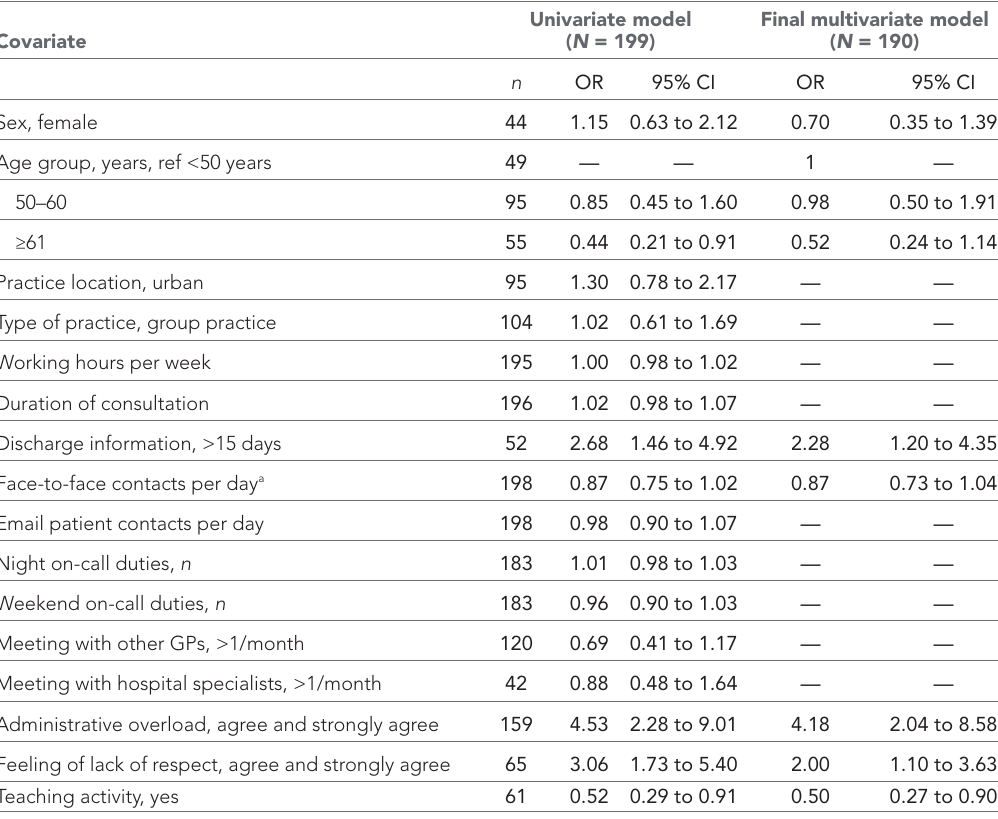
Table 3 Associations (odds ratios) between sociodemographic and work characteristics and GPs’ loss of meaning in